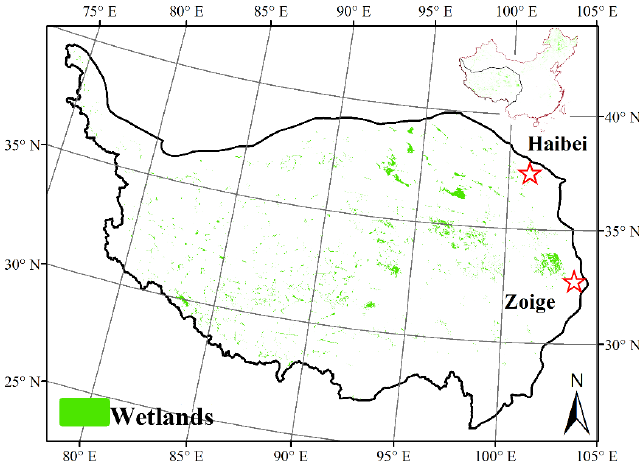
Figure 1. The distribution of natural wetlands across the Tibetan Plateau (data from Niu et al., 2012 [15]) and location of the study sites.